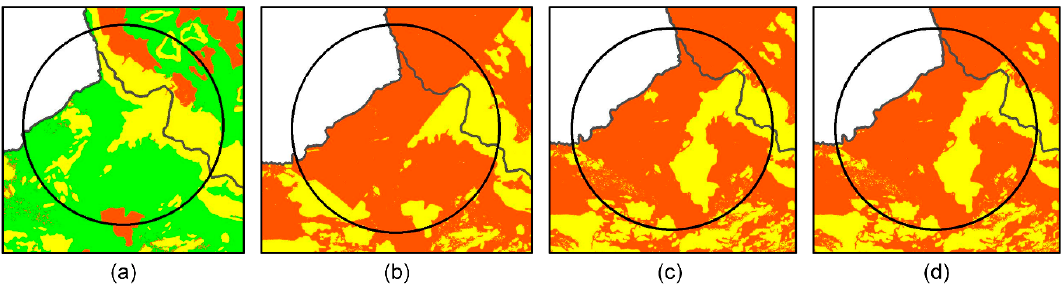
Figure 5. The extended area of the results for each method using the ( a ) parametric method, ( b ) AHP method, ( c ) triangular AHP method, and ( d ) trapezoidal AHP method.